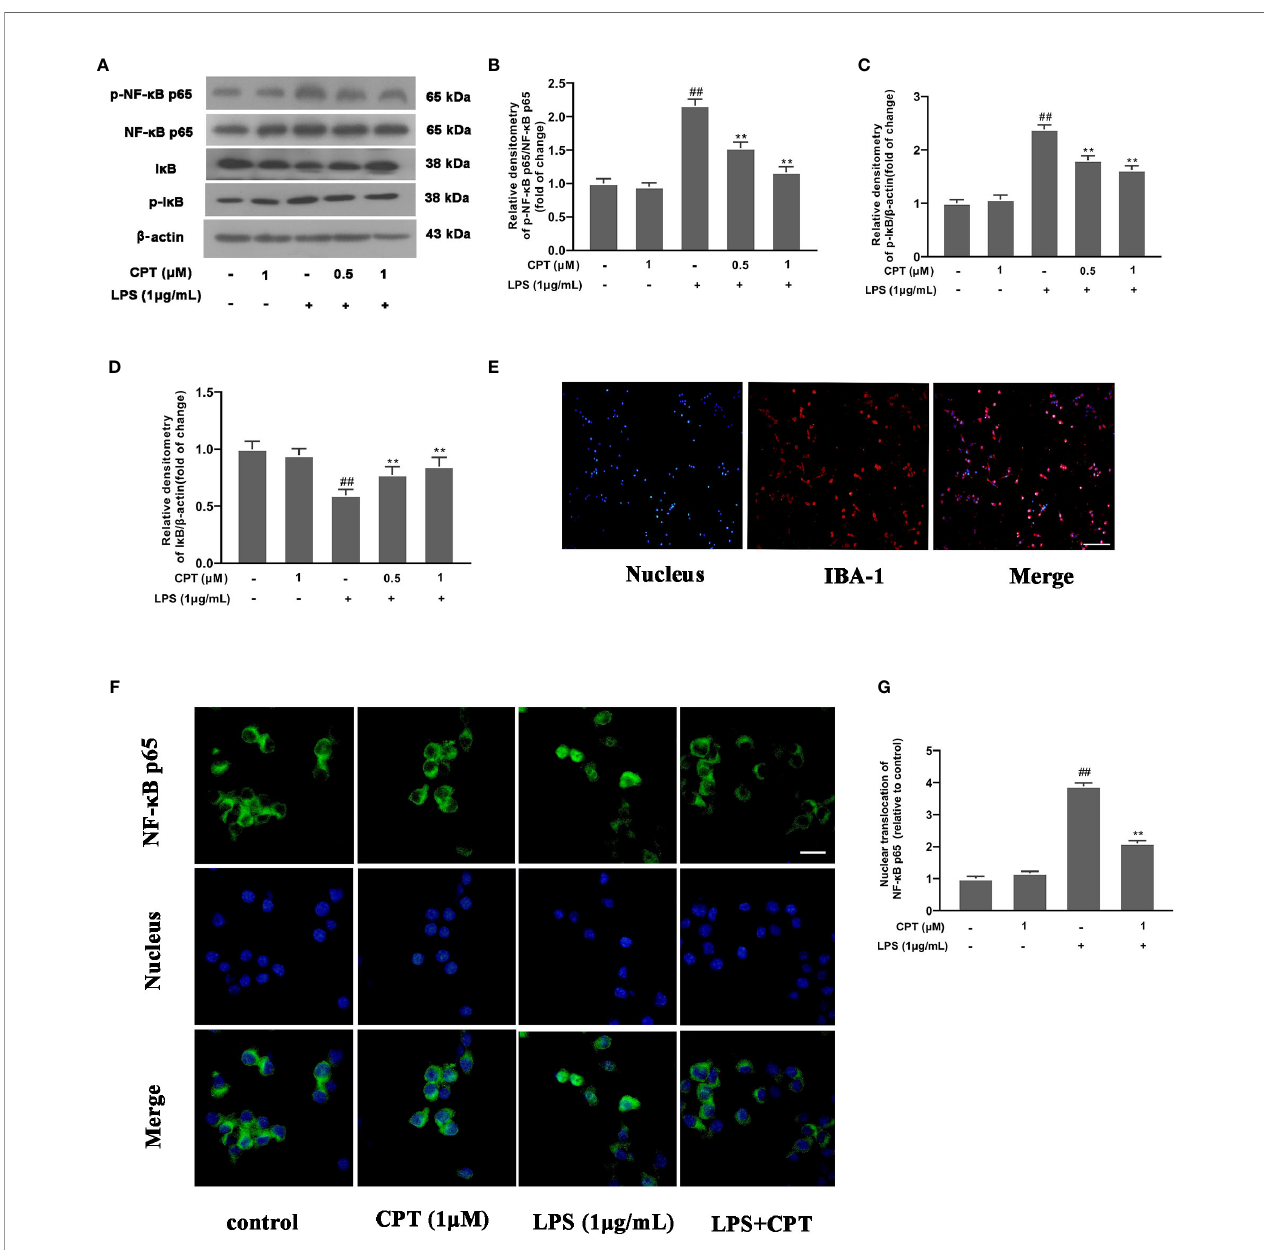
FIGURE 5 | CPT inhibits activation of NF- k B in LPS-exposed BV-2 cells. BV-2 cells were pretreated with CPT (0.5 m M and 1 m M) for 1 h and stimulated with LPS (1 m g/mL) for another 1 h. (A) The protein levels of I k B, NF- k B p65, and their phosphorylation were detected by western blot. (B) The levels of phos-NF- k B p65 were analyzed relative to NF- k B p65. (C, D) The levels of I k B and phos-I k B were analyzed relative to b -actin. (E) Microglia were labeled with IBA-1 by immuno fl uorescence staining (the scale bar represents 100 m m). (F, G) The nuclear translocation level of NF- k B p65 was examined by immuno fl uorescence staining (the scale bar represents 20 m m). Results are shown as means ± SD (n= 5). ## p < 0.01 vs. the untreated group (NT); **p < 0.01 vs. the LPS-exposed